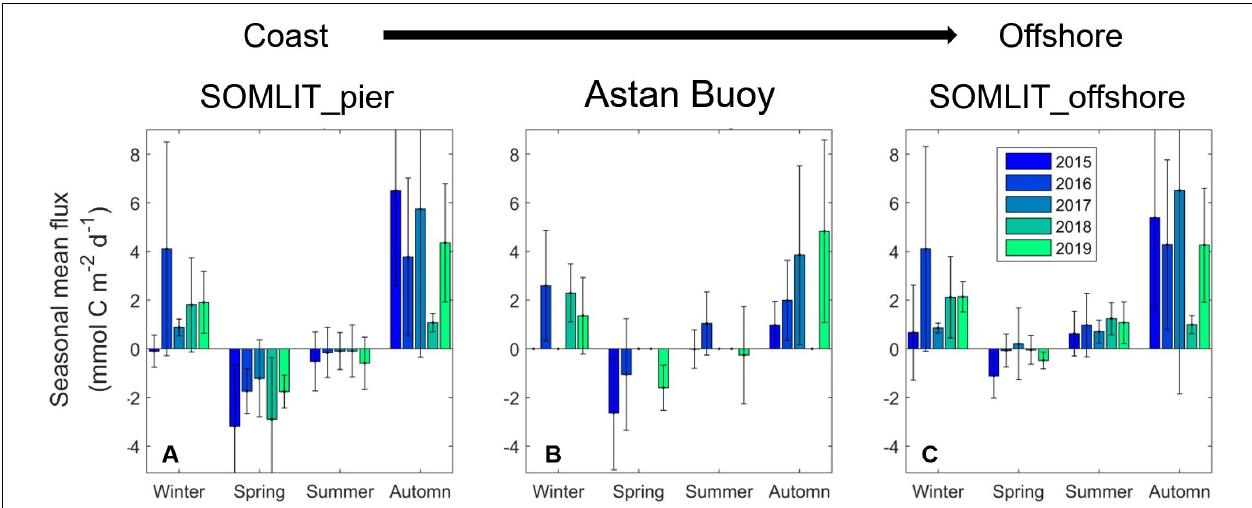
FIGURE 4 | Seasonal mean FCO 2 (mmol C m − 2 d − 1 ) across a coast-to-offshore gradient at (A) SOMLIT-pier (B) ASTAN buoy, and (C) SOMLIT-offshore from 2015 to 2019. The high frequency means were established only for seasons with a number of observations n obs > 1500, and for the bimonthly stations with a n obs > 4. The error lines represent the standard deviation.